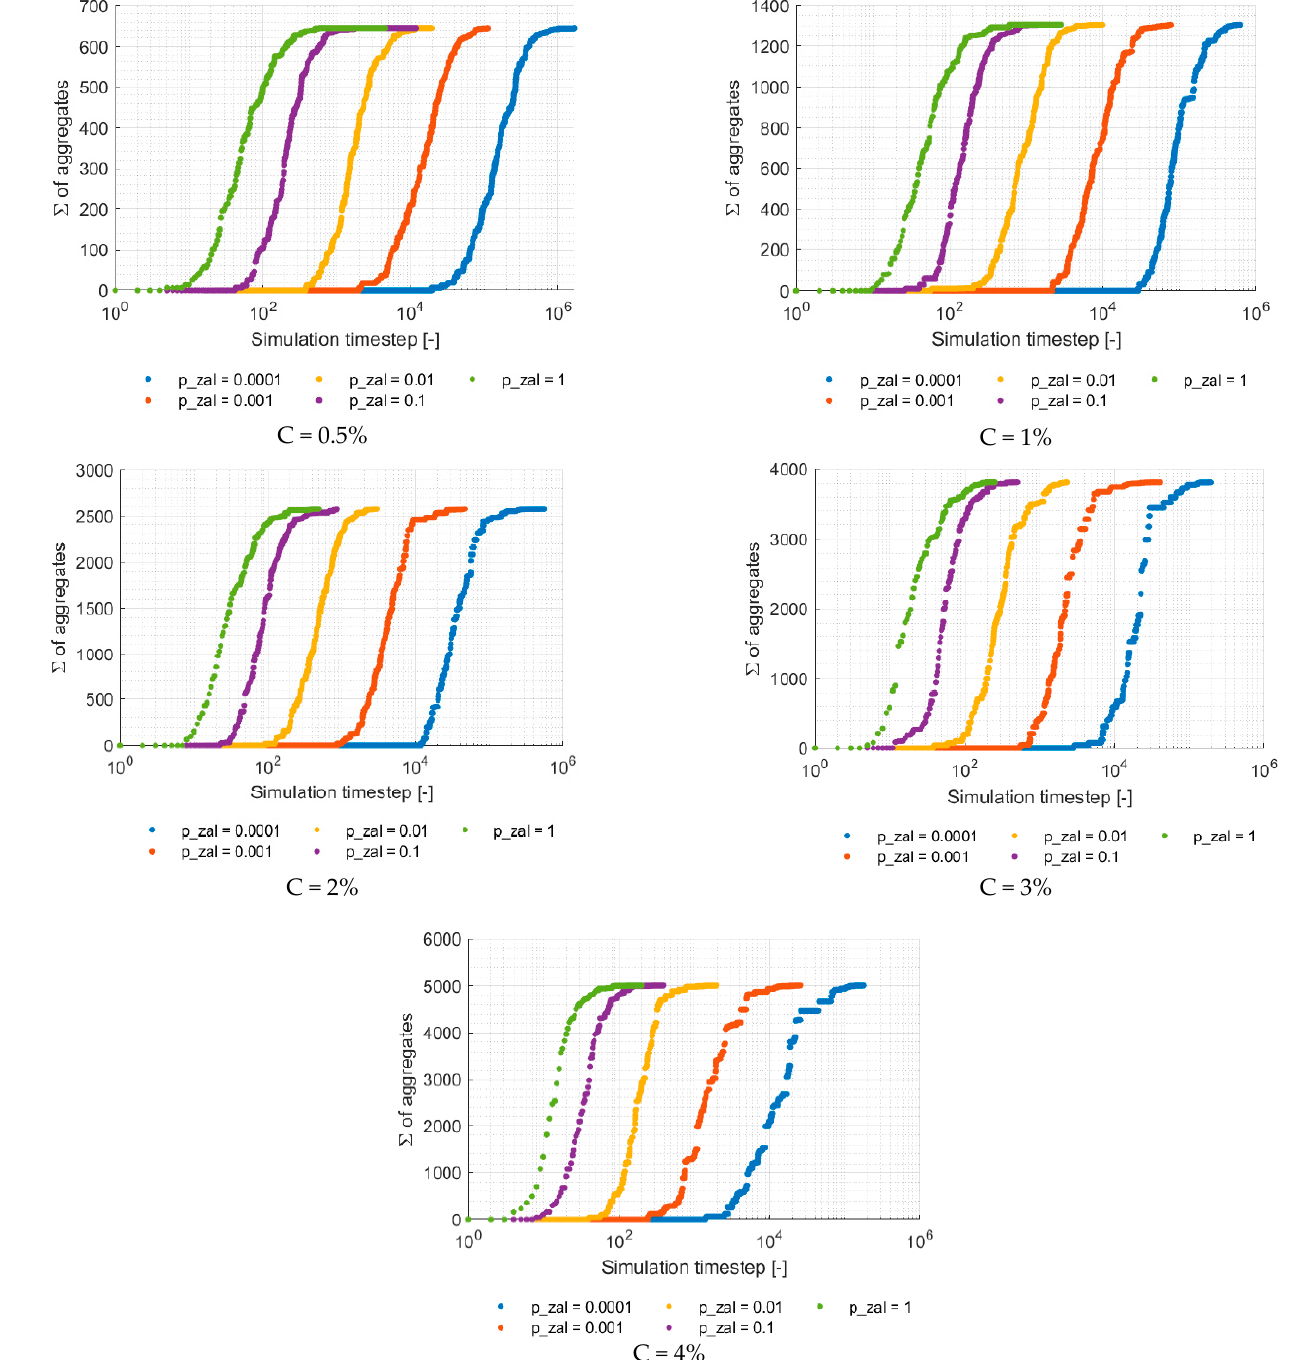
Figure A2. Kinetics curves obtained numerically for the all 25 cases.